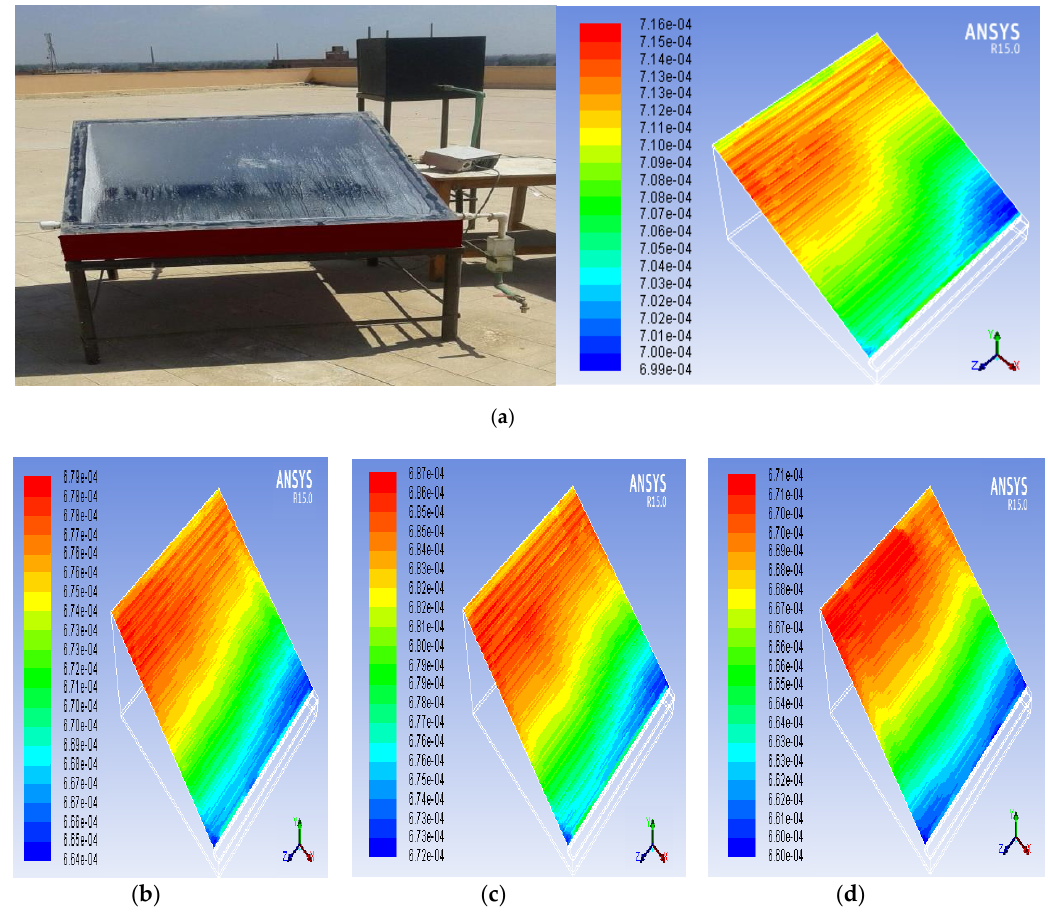
Figure 12. The contours of the volume fraction of water liquid on the condensing glass cover for the studied still with a water depth of 2 cm . ( a ) Water liquid contour at 10:00, ( b ) water liquid contour at 12:00, ( c ) water liquid contour at 14:00, ( c ) water liquid contour at 16:00.